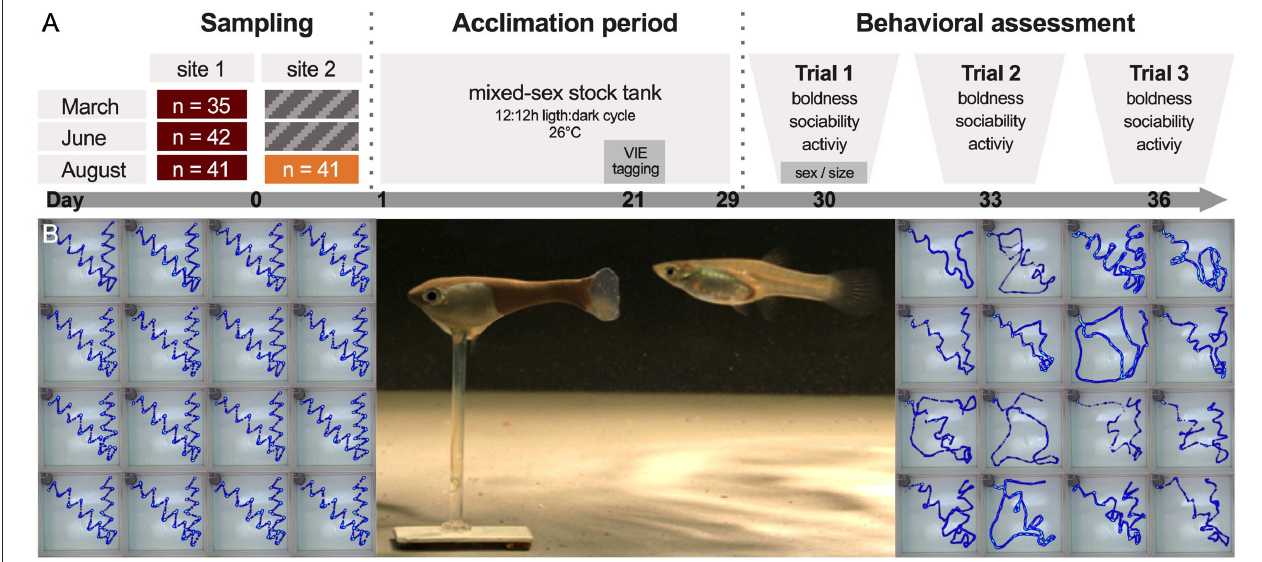
FIGURE 2 | Behavioral testing with robotic fish. (A) Test fish were collected three times and, when possible, at two sites (site 1 and 2, see Figure 1A ). After an initial 30-day acclimation period, fish were tested a total of three times (trial 1–3, sample sizes indicate tested individuals, for total catch numbers see Supplementary Table 2 ). ( B) During trials, the fish replica was moved remotely through the test tank (center). Once the focal individual had emerged from its shelter, the biomimetic robot initiated its predefined path (left) and the fish’s swimming trajectory was recorded